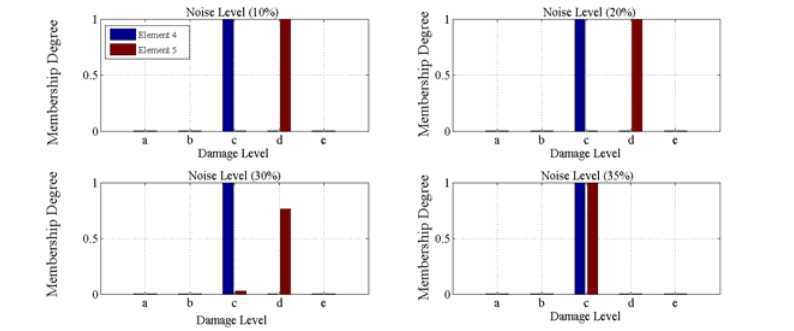
Fig. 13. Damage identification of case 3 with damage degree 10%-15%